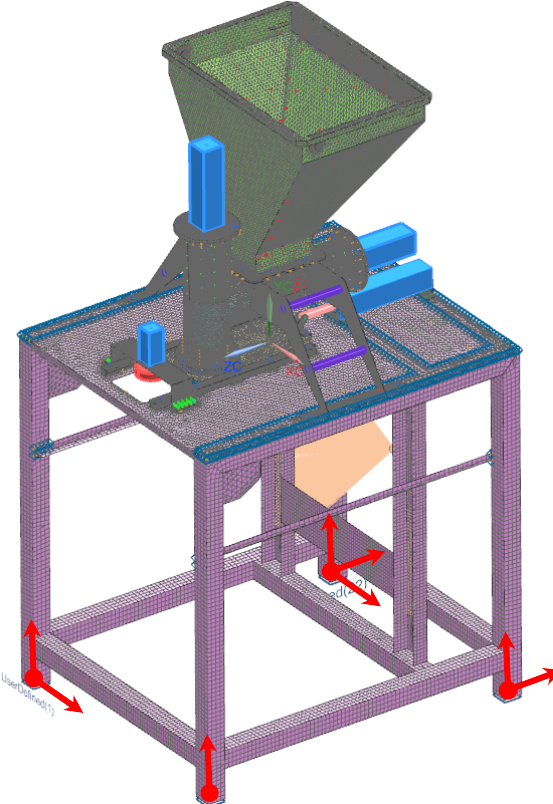
Figure 8. Location of degrees-of-freedom distribution: red vectors indicate directions along which movement is restricted.